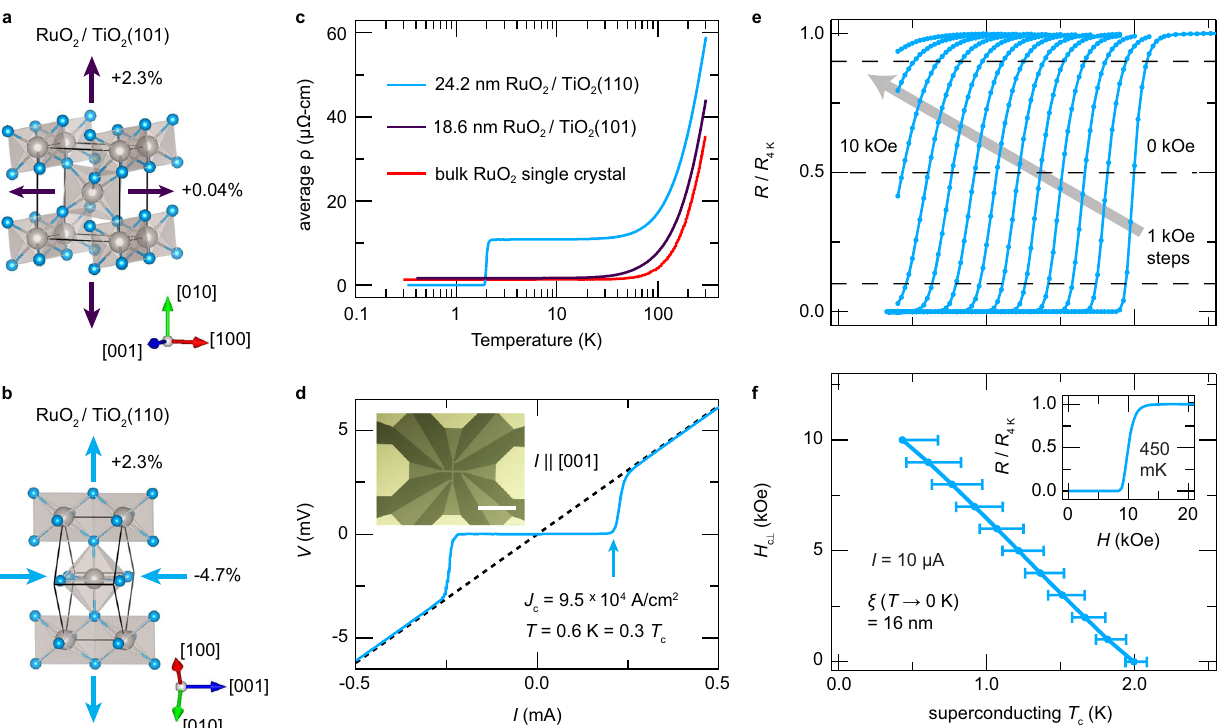
Fig. 1 Electrical transport behavior of bulk RuO 2 single crystals and epitaxially strained RuO 2 thin fi lms. a, b Schematic diagrams of the crystal structures and in-plane lattice mismatches with TiO 2 substrates of RuO 2 thin fi lms synthesized in (101)- and (110)-orientations. Gray and blue spheres represent Ru and O atoms, respectively. c Average resistivity versus temperature curves for 24.2 nm thick RuO 2 (110) and 18.6 nm thick RuO 2 (101) fi lms, compared to results for bulk RuO 2 single crystals from Ref. 15 . For clarity the bulk RuO 2 data have been rigidly shifted upward by 1 μΩ -cm ( ρ 0 ≈ 0.3 μΩ -cm). d V ( I ) curve measured at 0.6 K on a 10 μ m-wide resistivity bridge lithographically patterned on the RuO 2 (110) sample from ( c ) (as shown in the inset: scale bar = 200 μ m), which has the direction of current fl ow parallel to [001] rutile . Similarly large critical current densities J c are obtained with I jj½ 110 (cid:2) (Supplementary Note 1 and Supplementary Fig. 1). e, f Upper critical magnetic fi elds H c ⊥ versus superconducting T c s extracted from magnetoresistance measurements for the RuO 2 (110) sample in ( c ) along with a characteristic R ( H ) sweep acquired at 0.45K (inset in ( f )). Superconducting T c s are taken as the temperatures at which the resistance crosses 50% of its residual normal-state value R 4 K ; error bars on these T c s indicate where R crosses the 90% and 10% thresholds of R 4 K , respectively (cf. the horizontal dashed lines in ( e